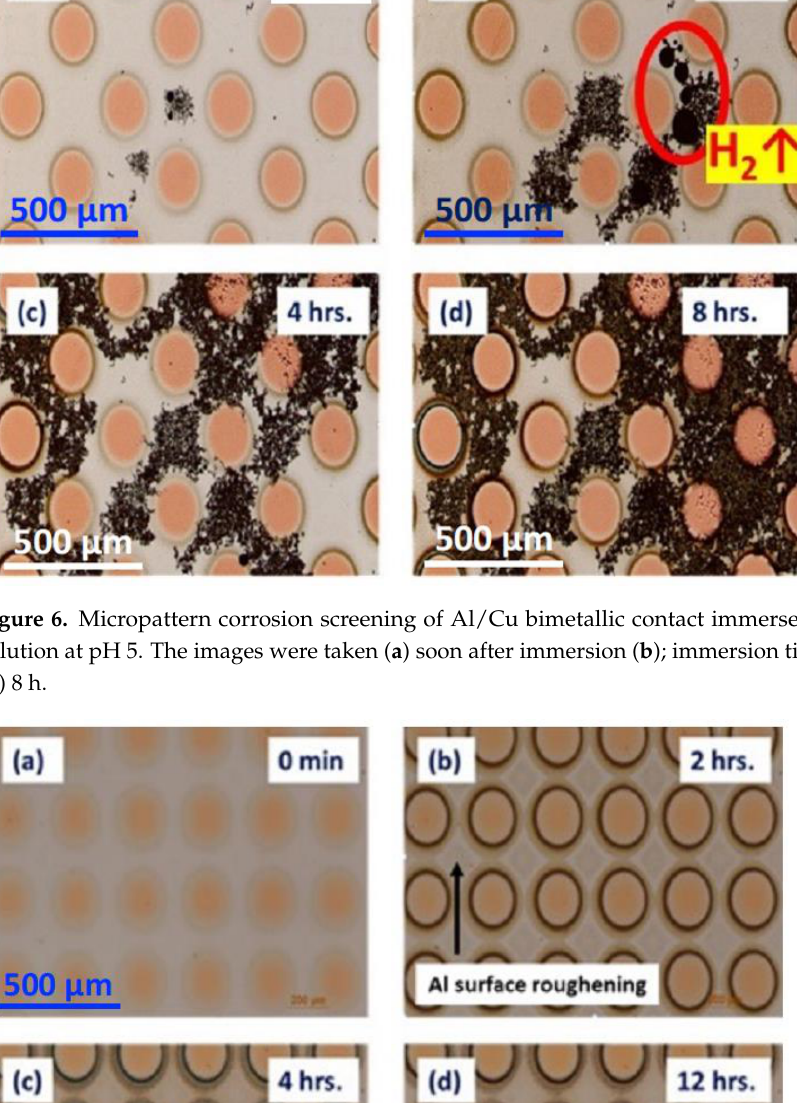
Figure 6. Micropattern corrosion screening of Al/Cu bimetallic contact immersed in 5 ppm Cl − solution at pH 5. The images were taken ( a ) soon after immersion ( b ); immersion time = 2 h, ( c ) 4 h, ( d ) 8 h.